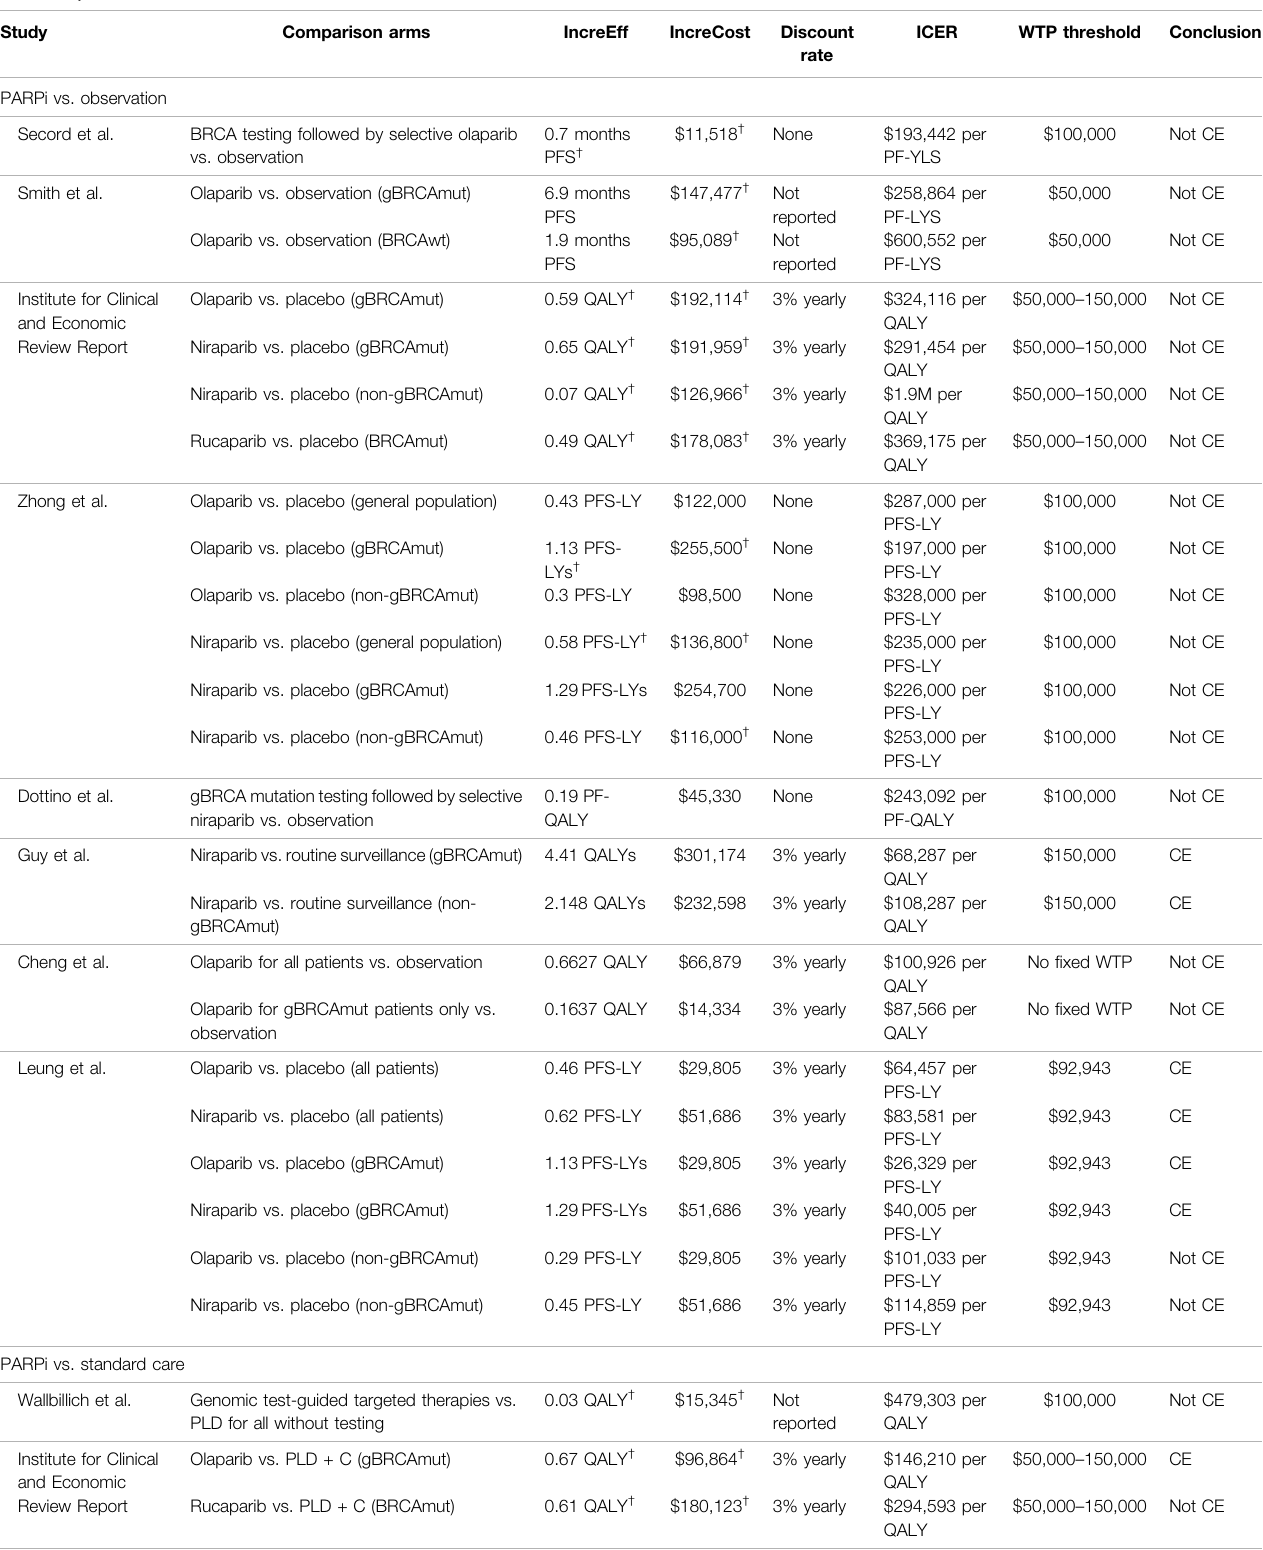
TABLE 2 | Details of economic evaluation outcomes of studies in recurrent advanced ovarian